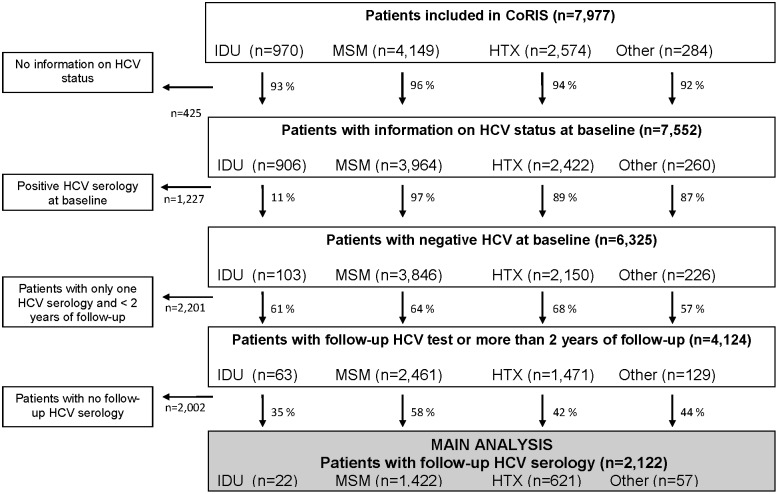
Patients flow-chart.